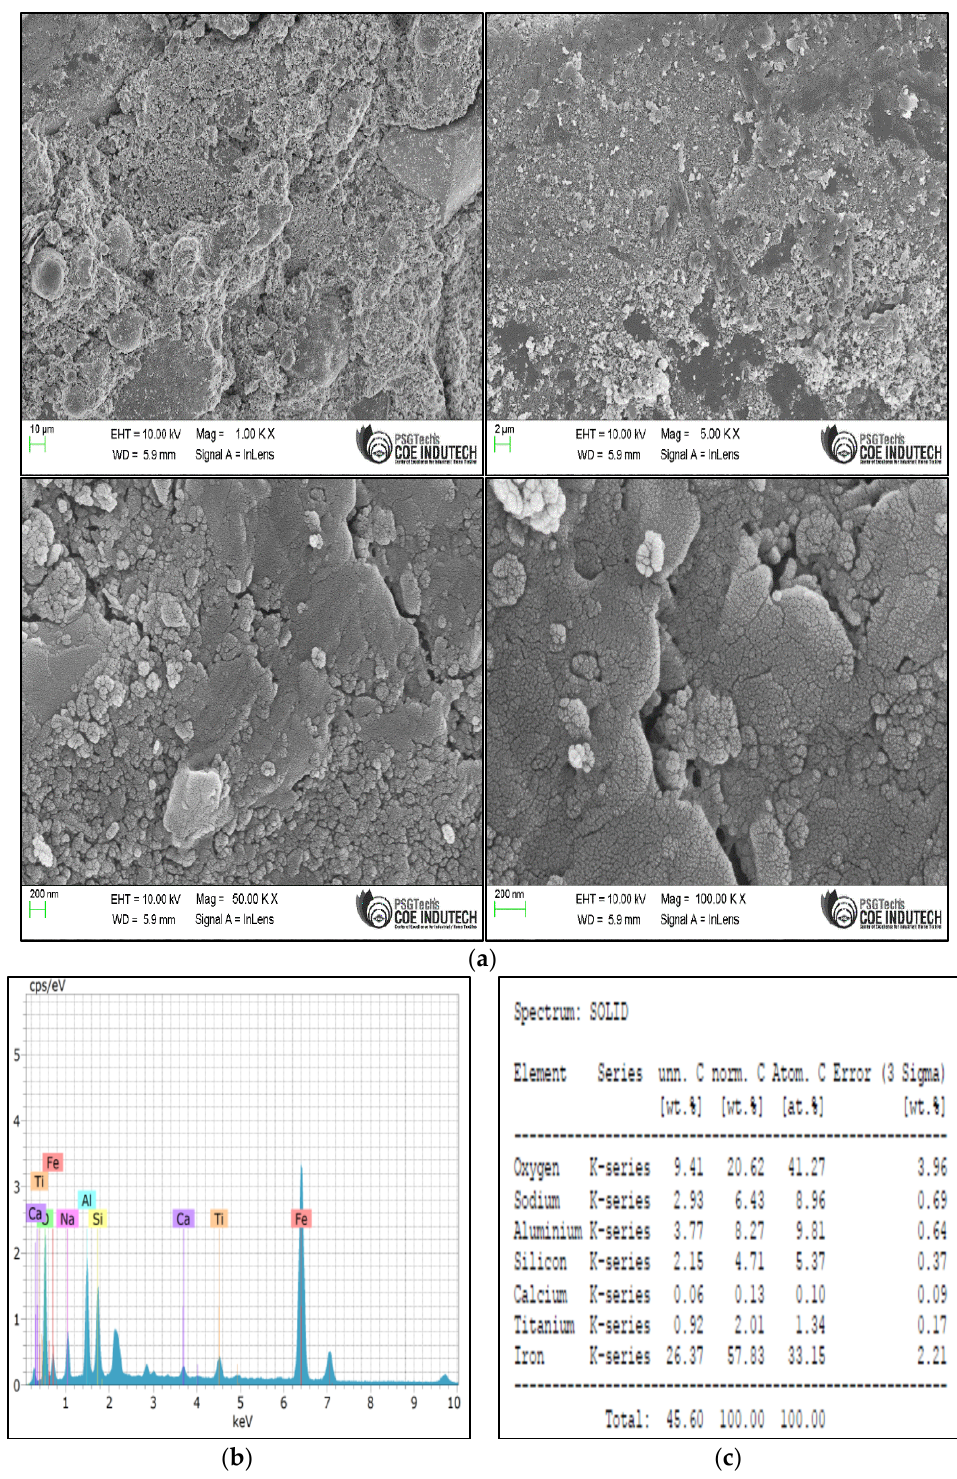
Figure 23. ( a ) Field emission scanning electron microscopy images of sustainable red mud brick. ( b , c ) Energy dispersive X-ray analysis of sustainable red mud brick. The XRD pattern in Figure 24 shows that the structure of the SRMBs are amorphous. The position of 0 2 Ɵ was from 5.47 to 33.71. Calcium europium manganese oxide and aluminium phosphate hydrate were given a pattern list score in the analysis. The wide hump clearly shows that the mineral phases were completely dissolved in the binding solution forming the geopolymerisation. The mass residue of the SRMBs was measured